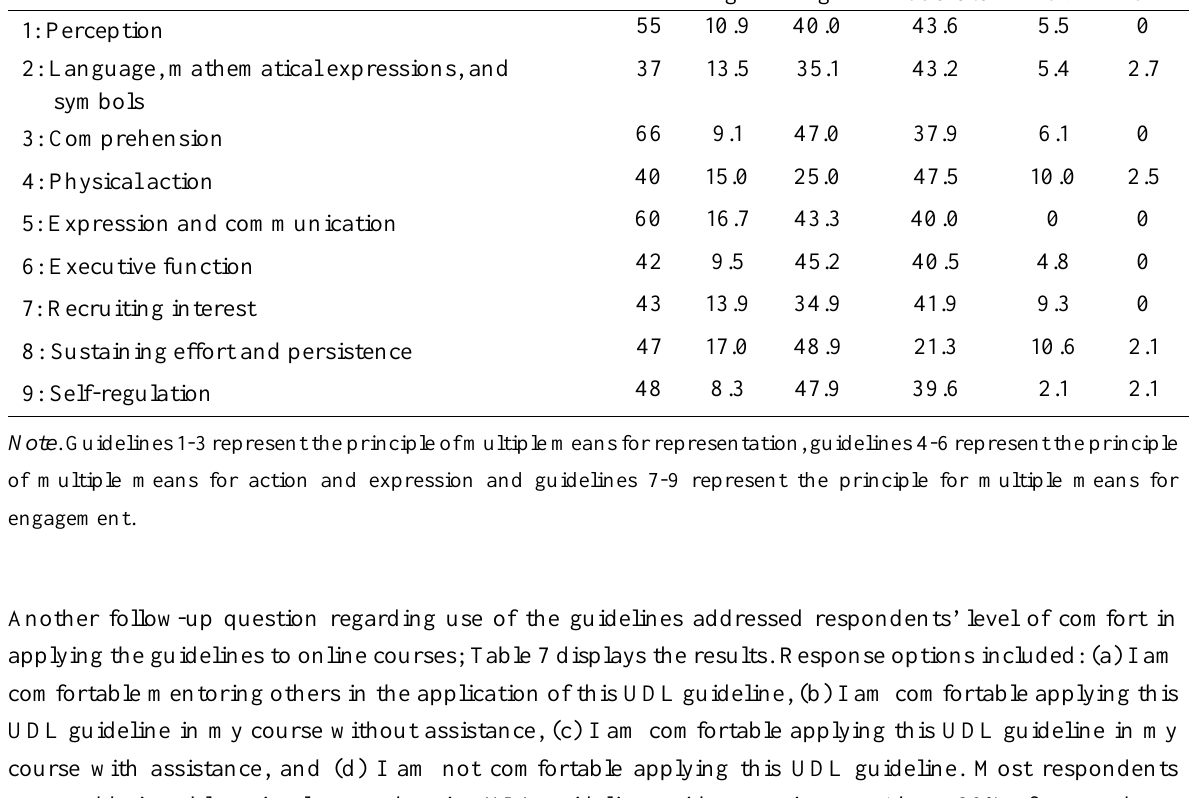
Very n high High Moderate Low